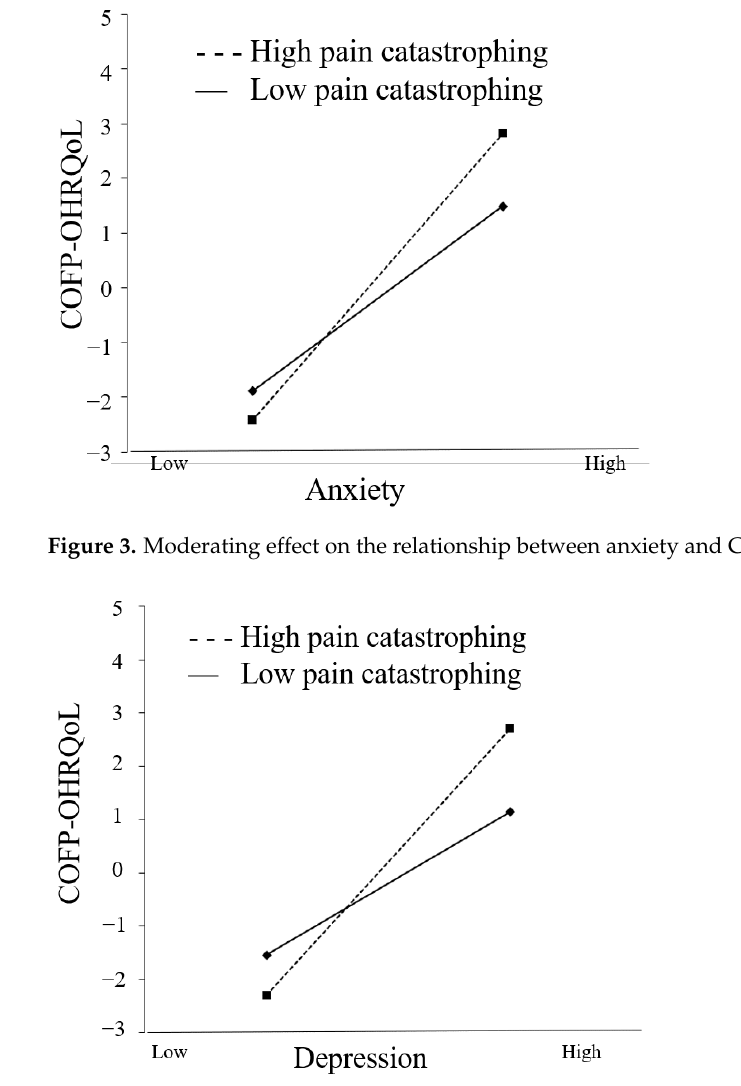
Figure 4. Moderating effect on the relationship between depression and